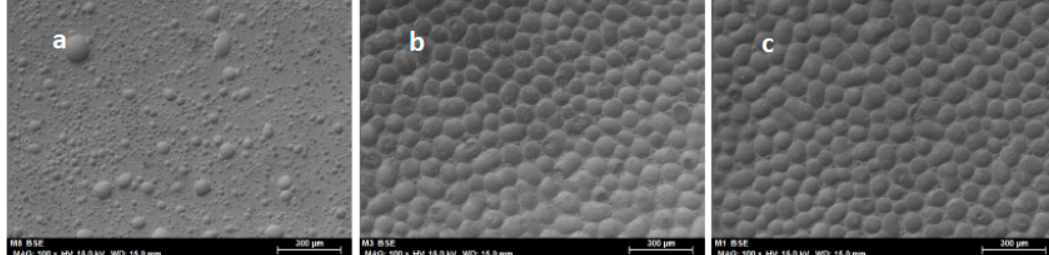
Figure 7. Scanning electron micrographs of the ionogel enzymatic derivative without crushing: (Enz-ionogel-B) (100 × ): ( a ) fresh (scale bar = 300 µ m), ( b ) after 1 cycle (scale bar = 300 µ m), and ( c ) after 5 cycles (scale bar = 300 µ m).